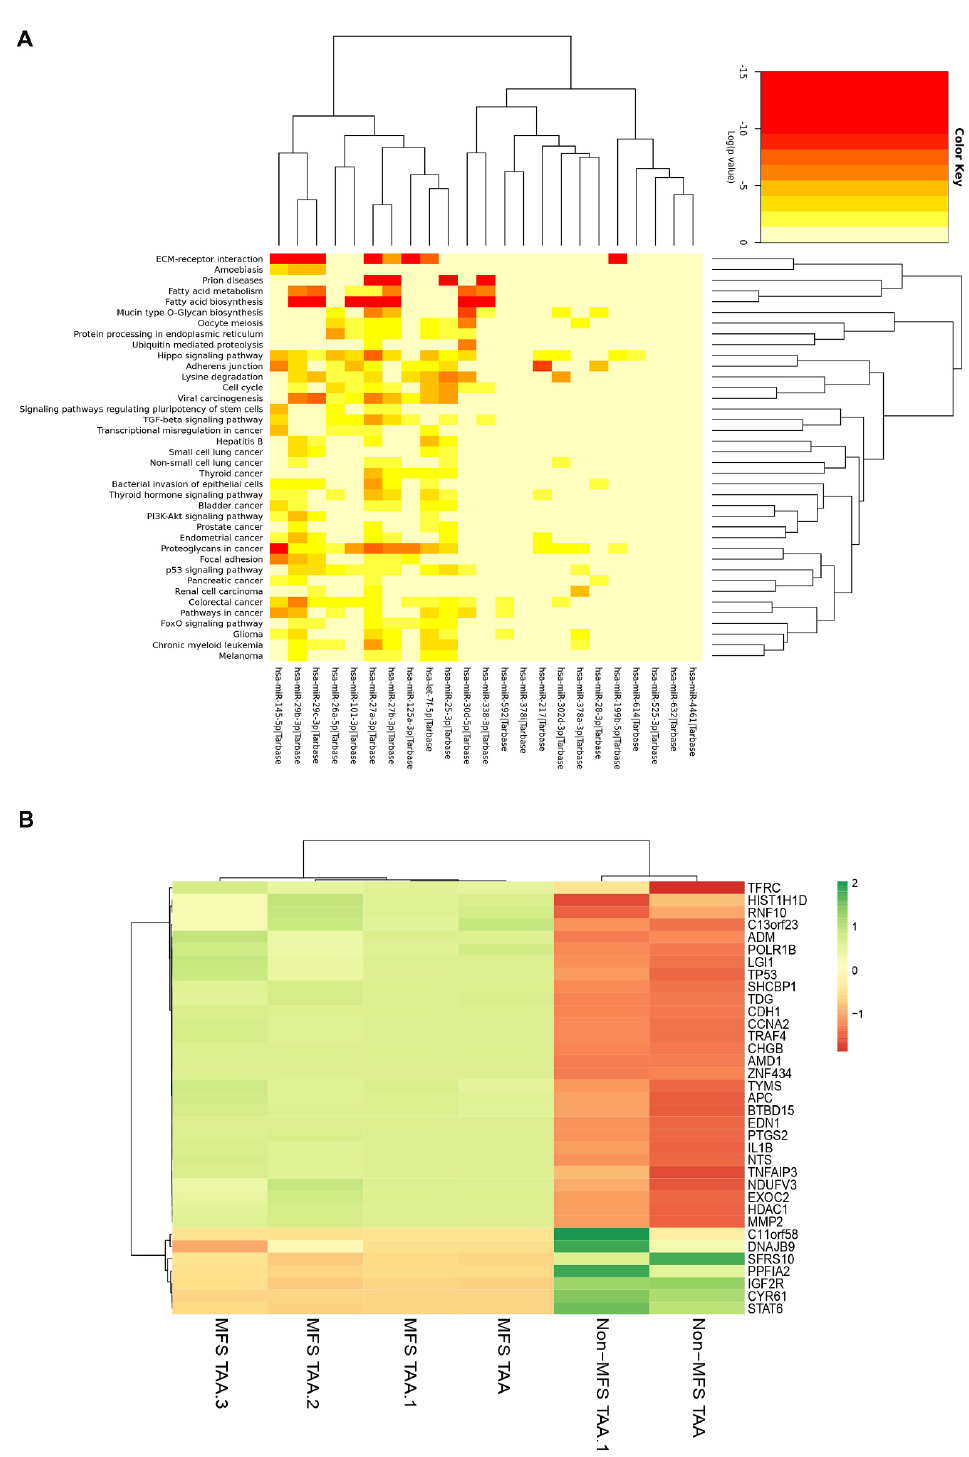
Figure 5. Representative intersection between deregulated miRNAs and their putative cellular pathways and expression analysis of miRNA target-genes in MFS TAA. ( A ) Heat map showing putative cellular pathways related to the deregulated miRNAs in MFS TAA medial tissue (MFS TAA, n = 4; non-MFS TAA, n = 4). Each column represents a single miRNA. ( B ) Heat map shows di ff erential gene expression in MFS TAA medial tissue ( n = 4) compared with non-MFS TAA ( n = 2). Red indicates downregulation and green indicates upregulation of genes. Black suggests no significant changes in gene expression